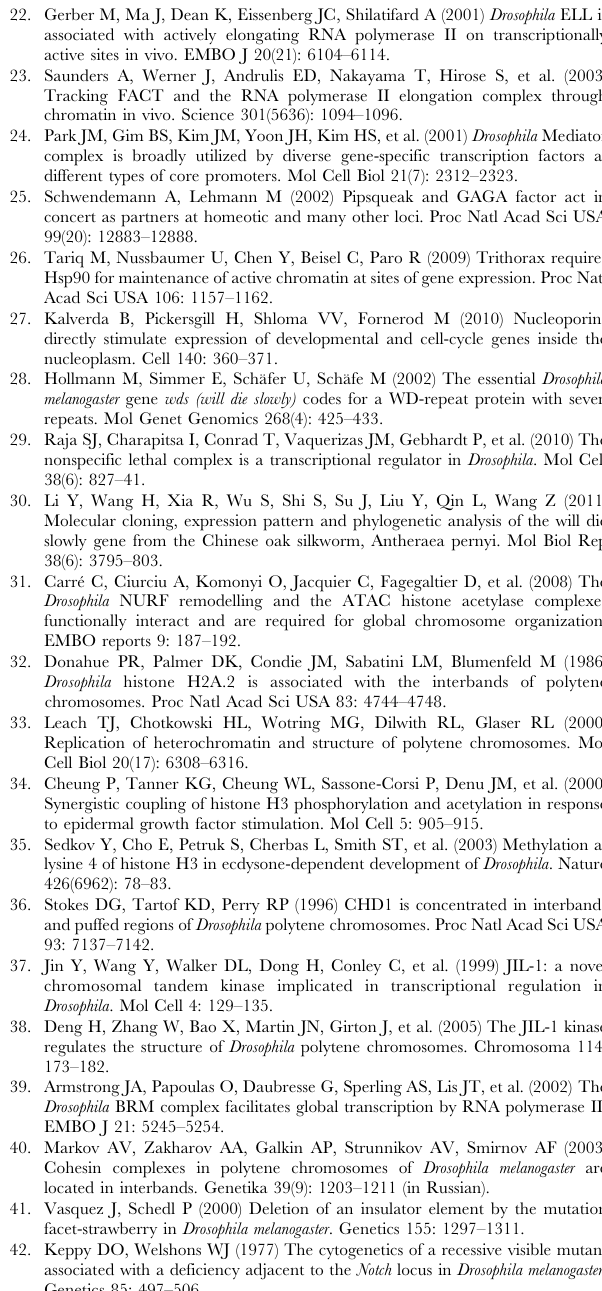
(Table 4). We used two types of data from modEncode: Smoothed M-value enrichment profiles represented as histograms and Regions of significant enrichment. Protocols of data processing are described in corresponding section of modMine (http:// intermine.modencode.org). Track for density of P- element insertion site was based on FlyBase, r5.32. We treated the data using the sliding window of 1 kb size with the step 500